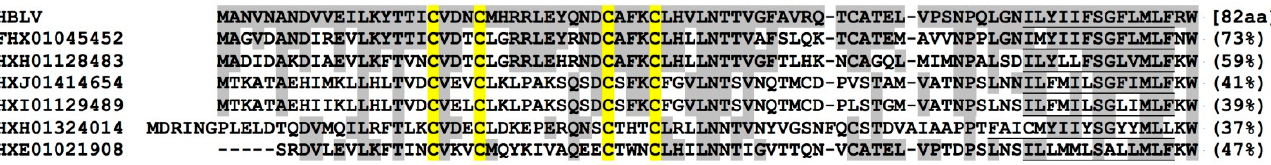
Figure 9. Multiple nucleotide sequence alignment of the N-terminal regions of ORF2 proteins encoded in the 3’-terminal regions of Dactylorhiza hatagirea beny-like virus (DHBLV) and predicted closely related VLRAs of reclovirids: Dactylorhiza fuchsii VLRA (GFHX01045452); Gymnadenia rhellicani VLRA TR40174 (GHXH01128483); Ophrys sphegodes VLRA (GHXJ01414654); Ophrys fusca VLRA (GHXI01129489); Gymnadenia rhellicani VLRA TR101479 (GHXH01324014); Gymnadenia x densiflora VLRA (GHXE01021908). Amino acid residues identical to those in DHBLV ORF2 protein are shaded. Conserved cysteines in the N-terminal sequences are in yellow. The hydrophobic sequences are underlined. The length of the presented DHBLV sequence is shown in square brackets, and identity to DHBLV protein is indicated on the right.